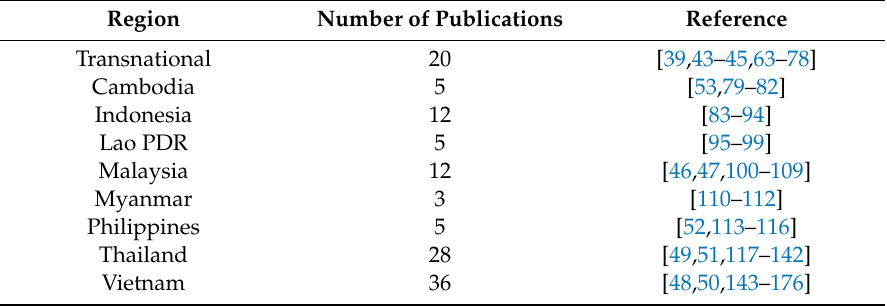
Table 1. References of the SWAT studies in Southeast Asia reviewed in this paper.